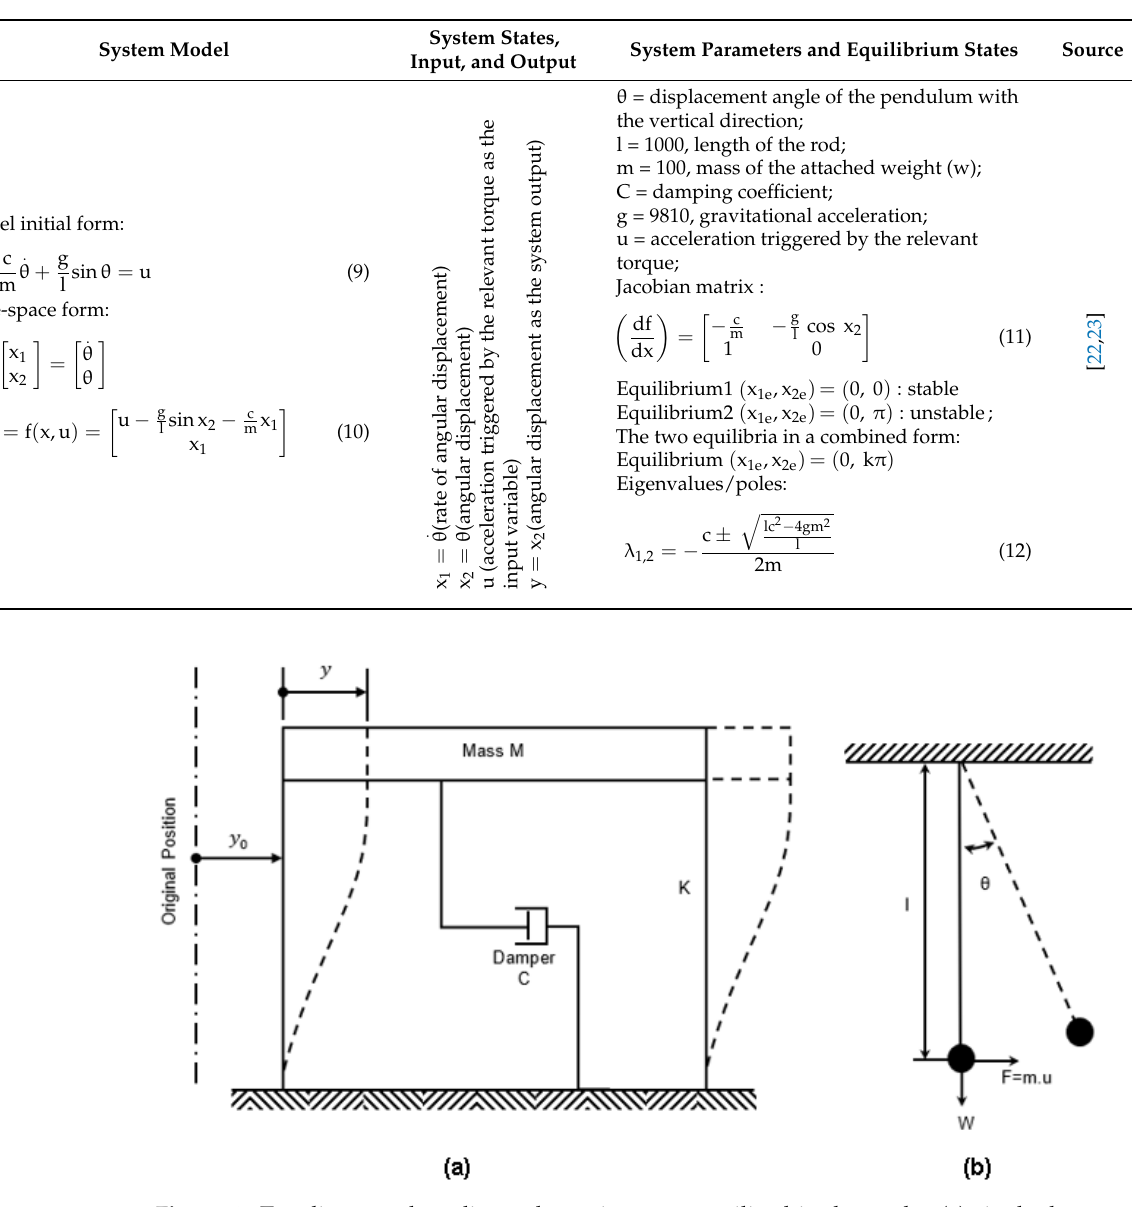
Table 2. Modern stability concepts terminology.